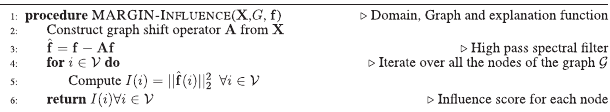
Algorithm 1 MARGIN ’ s simple in fl uence estimation.